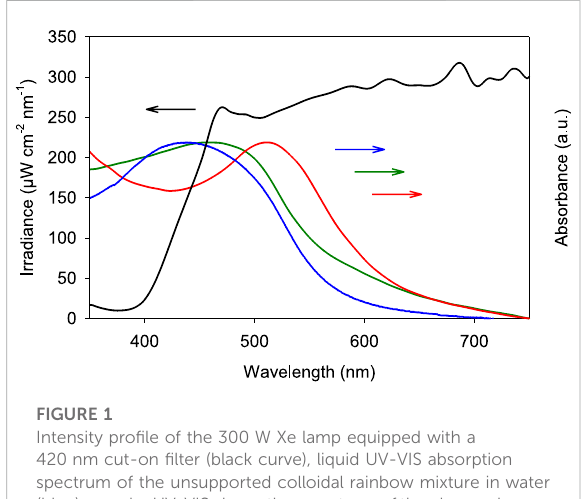
FIGURE 1 Intensity pro fi le of the 300 W Xe lamp equipped with a 420 nm cut-on fi lter (black curve), liquid UV-VIS absorption spectrum of the unsupported colloidal rainbow mixture in water (blue), powder UV-VIS absorption spectrum ofthe plasmonic rainbow sample on SiO 2 (green) and the plasmonic rainbow sample on SiO 2 suspendend in DMSO